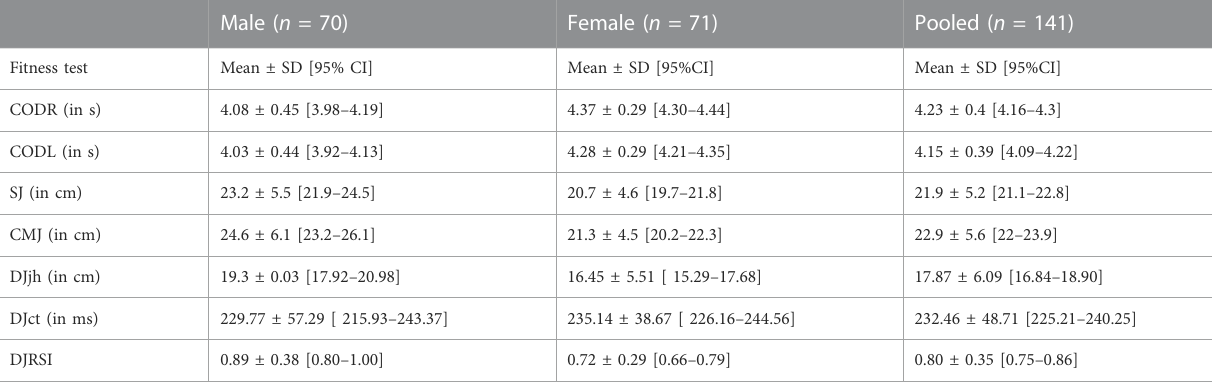
TABLE 1 Descriptive statistics (mean ± SD) and con fi dence intervals for the performance parameters.